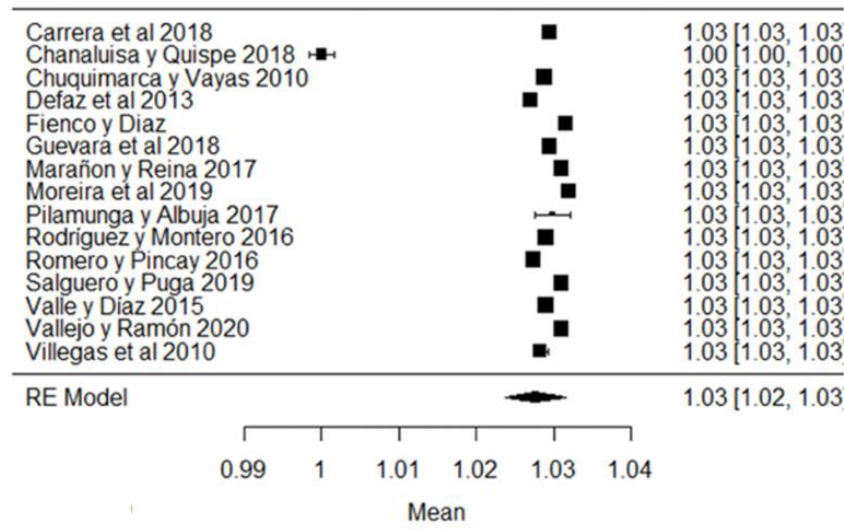
Figure 5. Forest plot of relative density [18,21,23,24,26,36,38,39,44,51,57,60,61,66,79].